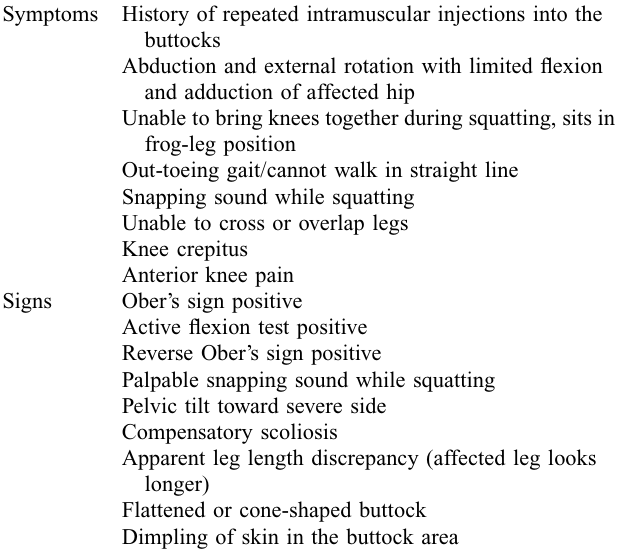
Table 1. Clinical features of gluteal muscle contracture. Symptoms History of repeated intramuscular injections into the